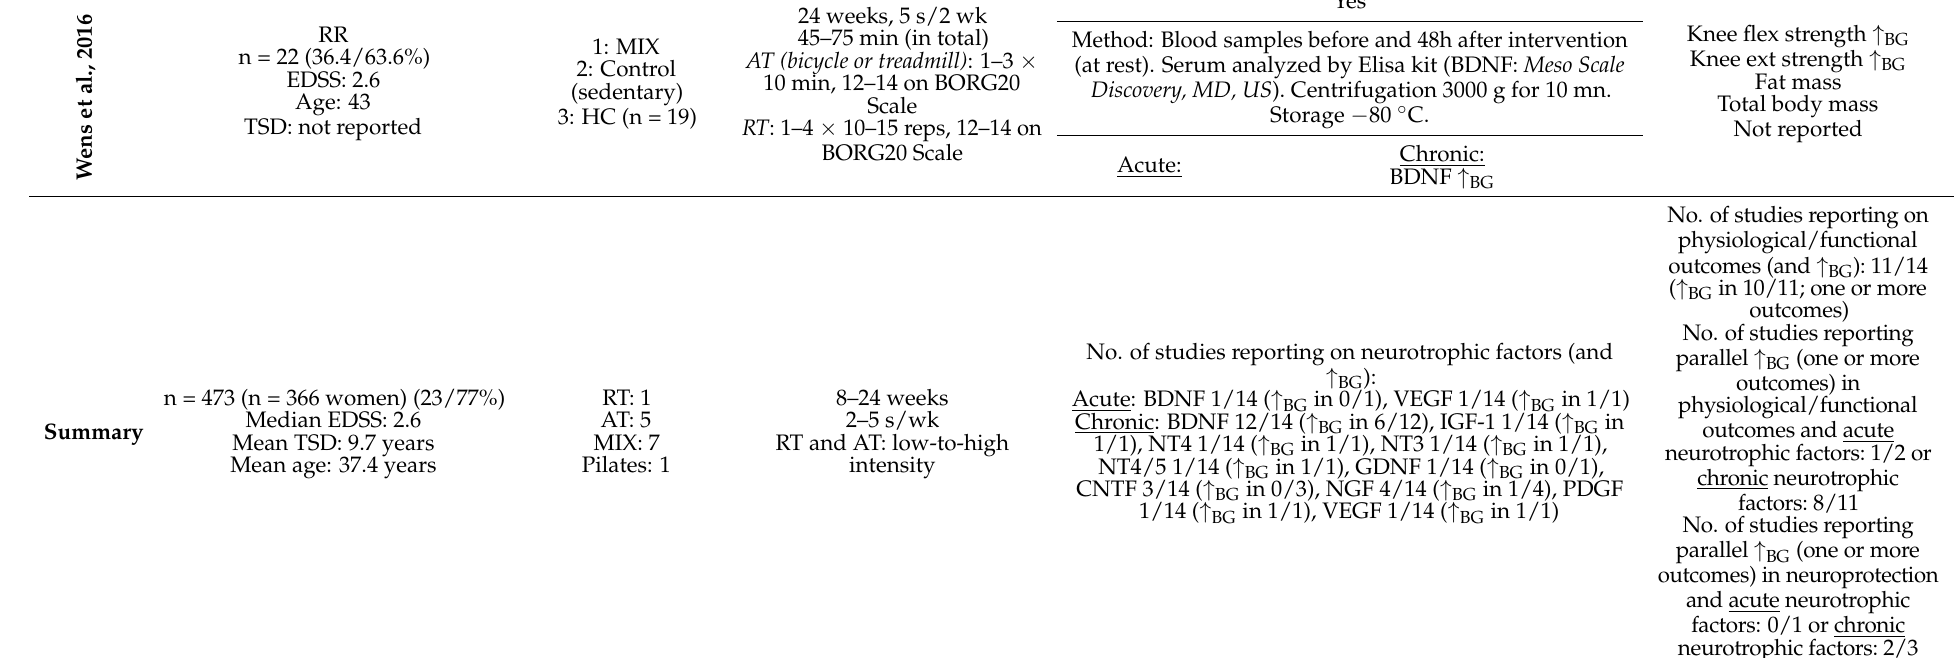
Physiological and/or Functional